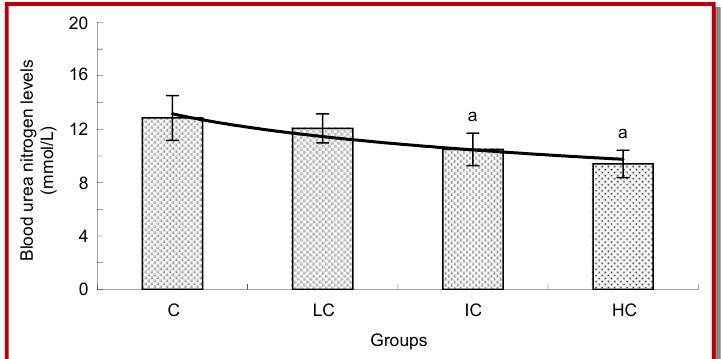
Figure 3: The effects of CSP on the blood urea nitrogen levels of mice. Data are expressed as mean ± S.D. a p<0.05 compared with control group